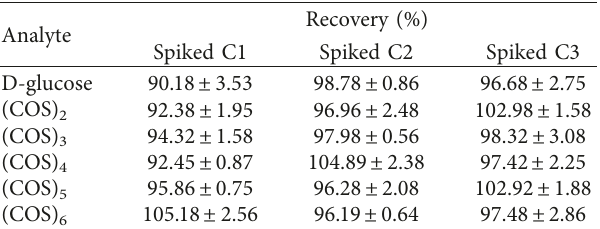
Table 5: Determination of method accuracy given as recovery using the standard addition